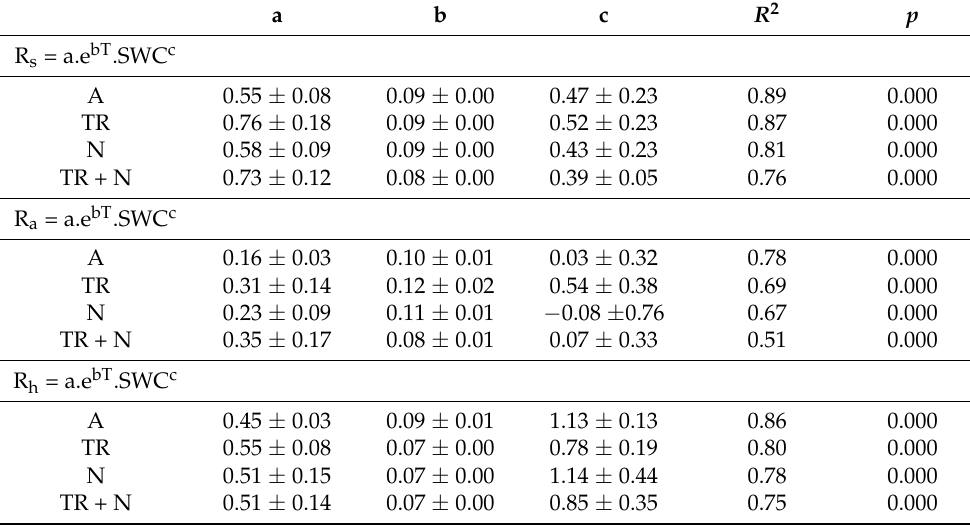
Table 2. Parameter estimates of bivariate exponential models for R s , R a , and R h as a function of soil temperature (T) and moisture (SWC) in the 0–10 cm soil from September 2017 to August 2018 in different treatments (mean ± SE).